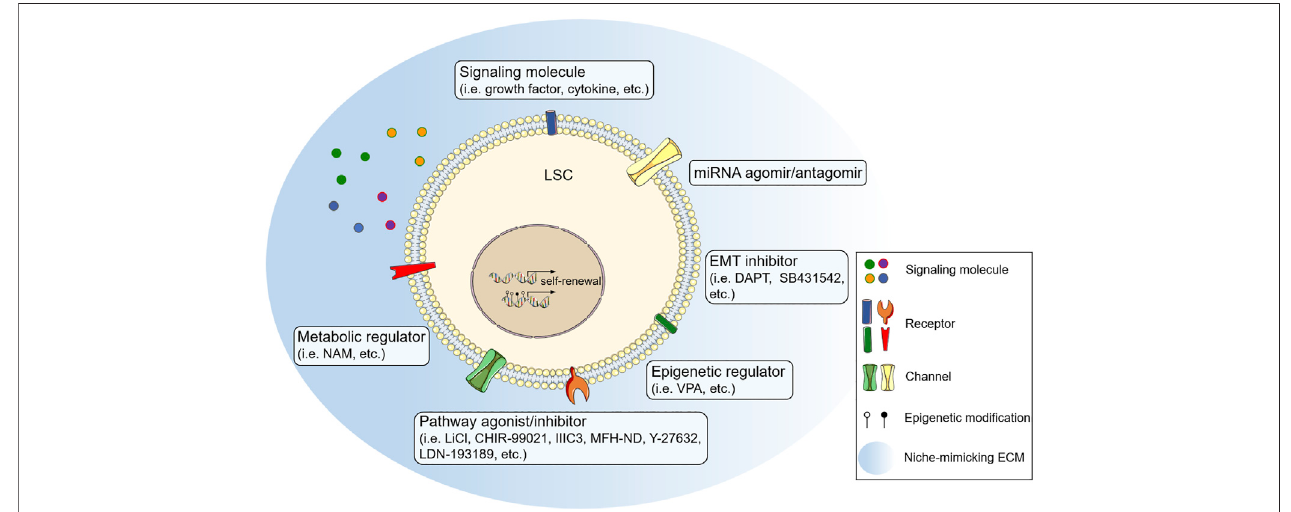
FIGURE1| Small-molecularcombinationasanovelstrategytooptimizelimbalstemcell(LSC)expansioninculture. GSK3 β inhibitors [lithium chloride(LiCl),CHIR- 99021],DKKinhibitor(IIIC3),andWntmimic(MFH-ND)activatethecanonicalWntpathway toimproveLSCexpansion.Growthfactor (pigmentepithelial-derivedfactor), cytokine (leukemia inhibitory factor), ROCK inhibitor (Y-27632), and BMP signaling inhibitor (LDN-193189) also promote LSC self-renewal through multiple signaling pathways. TGF/ β signaling inhibitor (SB431542) and Notch signaling inhibitor (DAPT) prevent epithelial – mesenchymal transition of LSC by inhibiting the corresponding pathways. Histone deacetylase inhibitor (VPA), miRNA agomir/antagomir and nicotinamide adenine dinucleotide (NAD + ) precursor [nicotinamide (NAM)] mightenhancetheef fi ciencyofLSCexpansionthroughtheregulationatepigenetic,post-transcriptional,andmetaboliclevels.ECM,extracellularmatrix;EMT,epithelial- mesenchymal transition; miRNA,